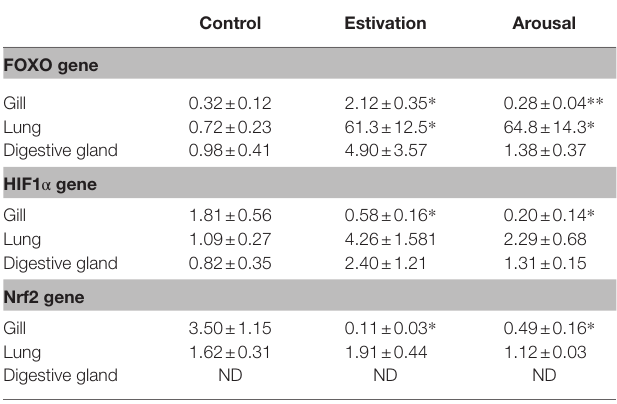
TABLE 1 | REDOX-sensitive transcription factors expression in tissues of P. canaliculata exposed to short term activity–estivation–arousal cycle.